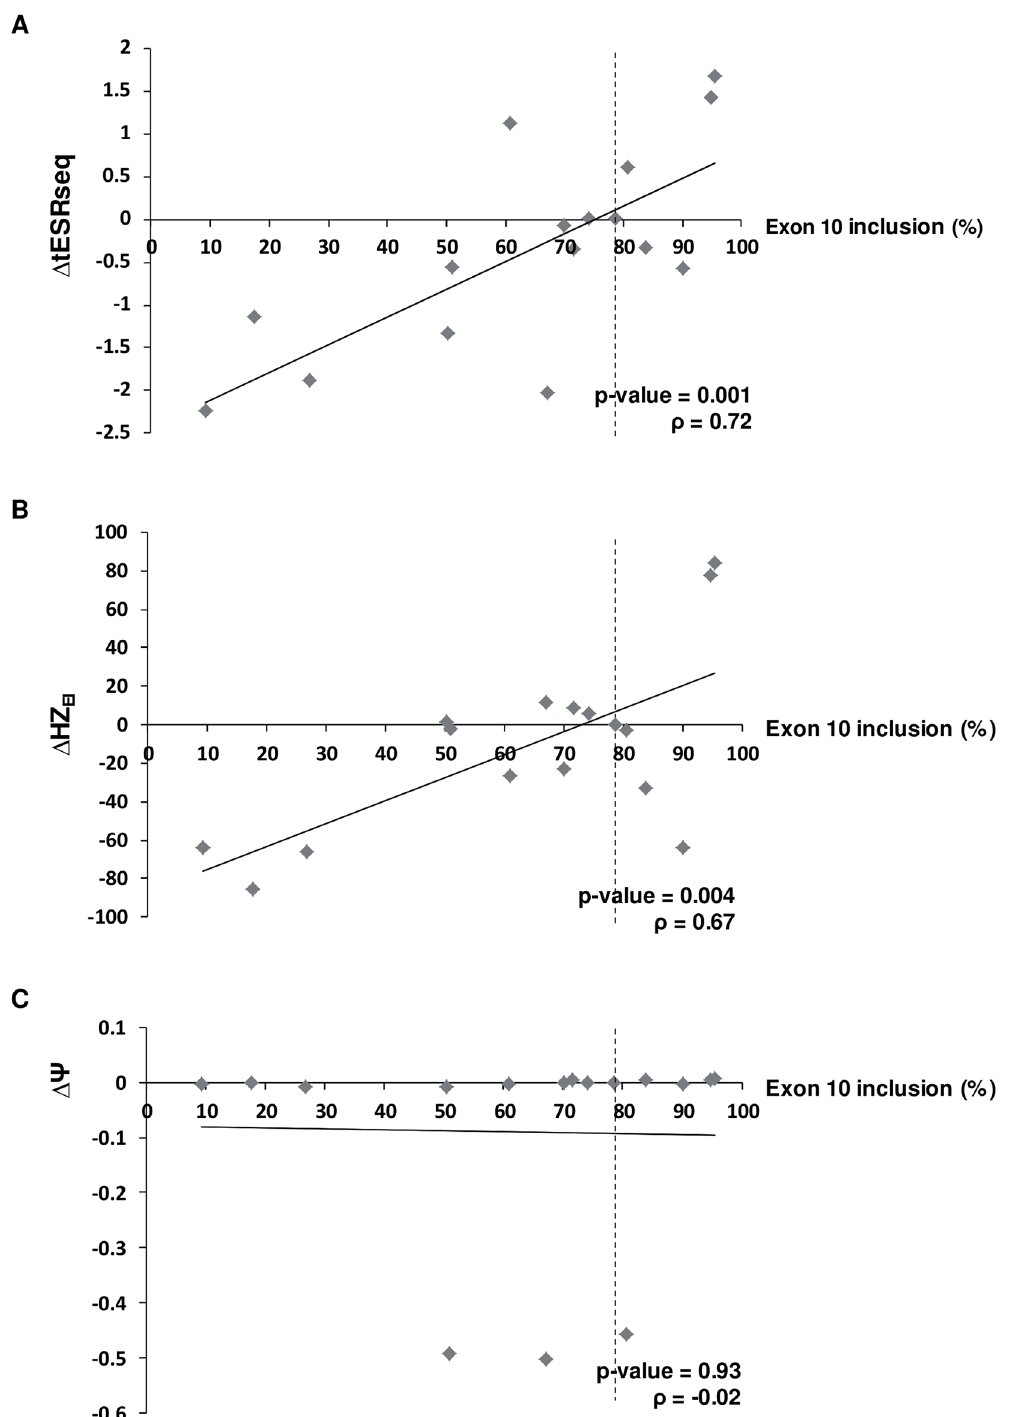
Fig 4. Correlation analysis between exon 10 inclusion levels and results obtained from new ESR-dedicated bioinformatics tools. (A), (B) and (C) refer to results obtained with Δ tESRseq-, Δ HZ EI- and ΔΨ -based bioinformatics approaches, respectively, as described under Materials and Methods. Only MLH1 exon 10 variants located outside the sequences that define the reference splice sites were retained for this analysis as already mentioned in Fig 3. The precise correspondence between each Δ value ( Δ tESRseq, Δ HZ EI or ΔΨ ), the level of exon inclusion observed in the pSPL3m-M1e10 minigene assay, and the identity of the corresponding MLH1 exon 10 variant, is indicated on S1 Table. Correlation coefficients (r) and p-values were determined by performing a Pearson correlation analysis, as described under Materials and Methods.